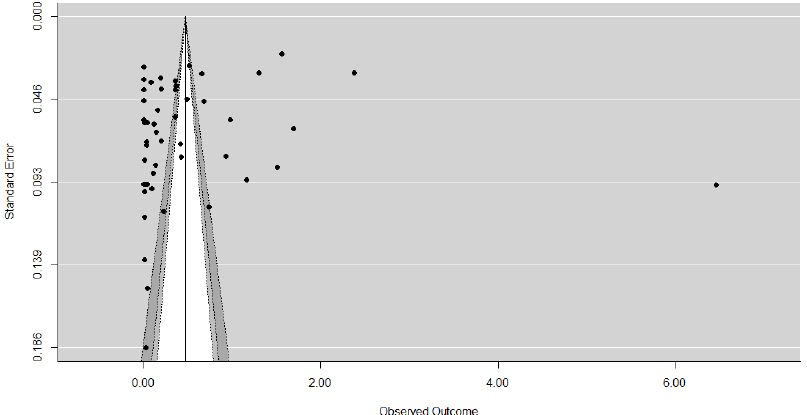
Figure 4. A contour enhanced funnel plot for aggregated values ( n = 54). Light grey is <1% significance, medium grey is 1%–<5% significance, dark grey is 5%–10% significance, and the white is the area of non-significance.